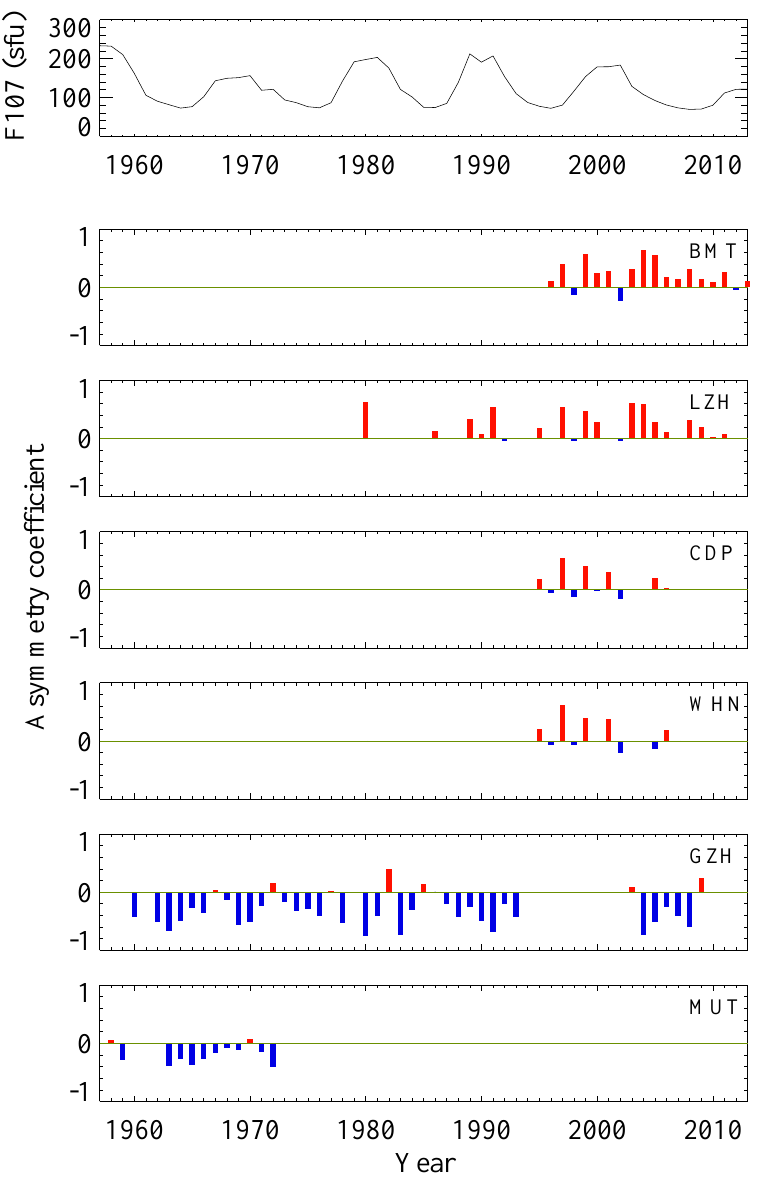
Figure 6. ( Top ): yearly averaged F107 index over the period from 1957 to 2013. ( Bottom ): Equinoctial asymmetry coefficient calculated at each observatory for years with available observations and shown in red and blue bars for the positive and negative values respectively.